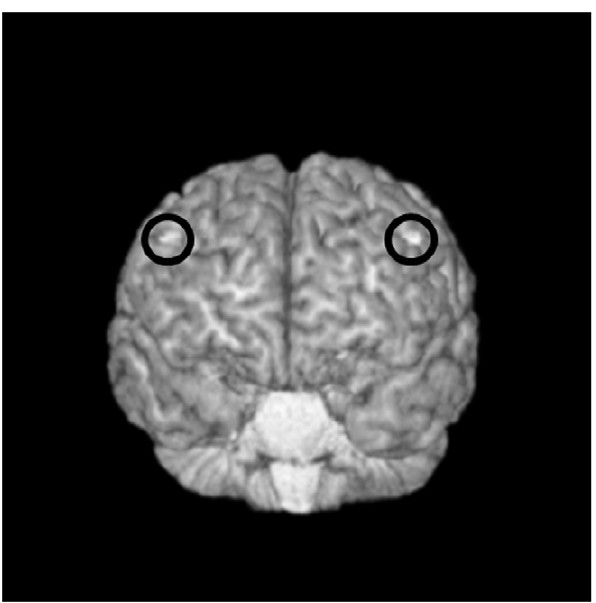
Figure 2. Targeting the Dorsolateral Prefrontal Cortex (DLPFC) for rTMS stimulation. Transverse view from a single subject with exposed cortex and overlap of Brodmann areas 9 & 46, highlighted (white) on a T1-weighted 3D MRI. Using MRI-to-MiniBird co-registration, the centre of the TMS coil was held over this region.